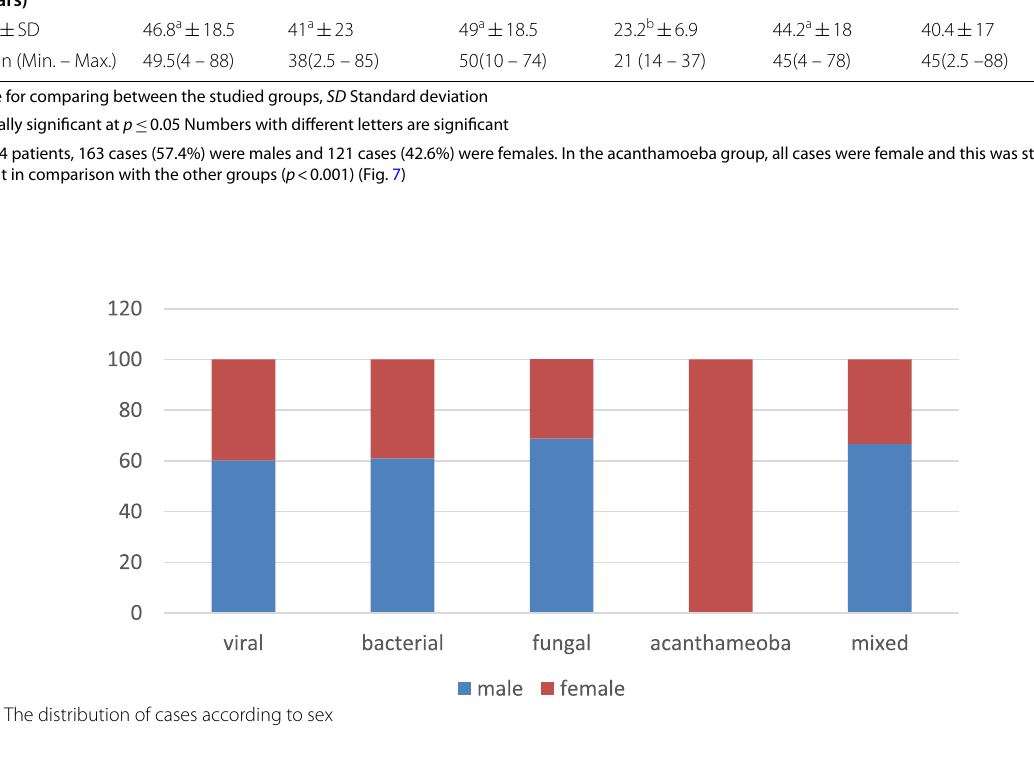
Table 1 Comparison between MK groups according to age